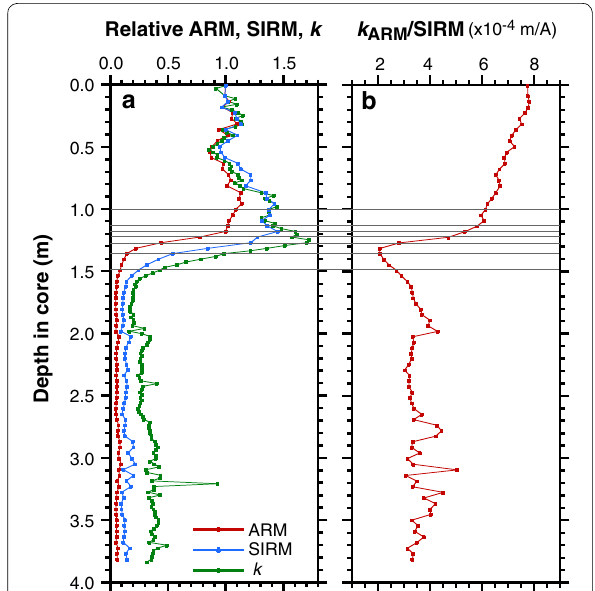
Fig. 2 Variations of magnetic-mineral concentration and grain size with depth in core GH98-1232. a Relative variations of anhysteretic remanent magnetization (ARM) (red), saturation isothermal remanent magnetization (SIRM) (green), and magnetic susceptibility ( k ) (blue) after Yamazaki et al. (2003). b The ratio of ARM susceptibility ( k ARM ) to SIRM. Smaller ratios are interpreted to be indicative of larger average magnetic grain sizes. Thin horizontal lines indicate depth horizons for samples for which datasets are shown in Figs. 3 and